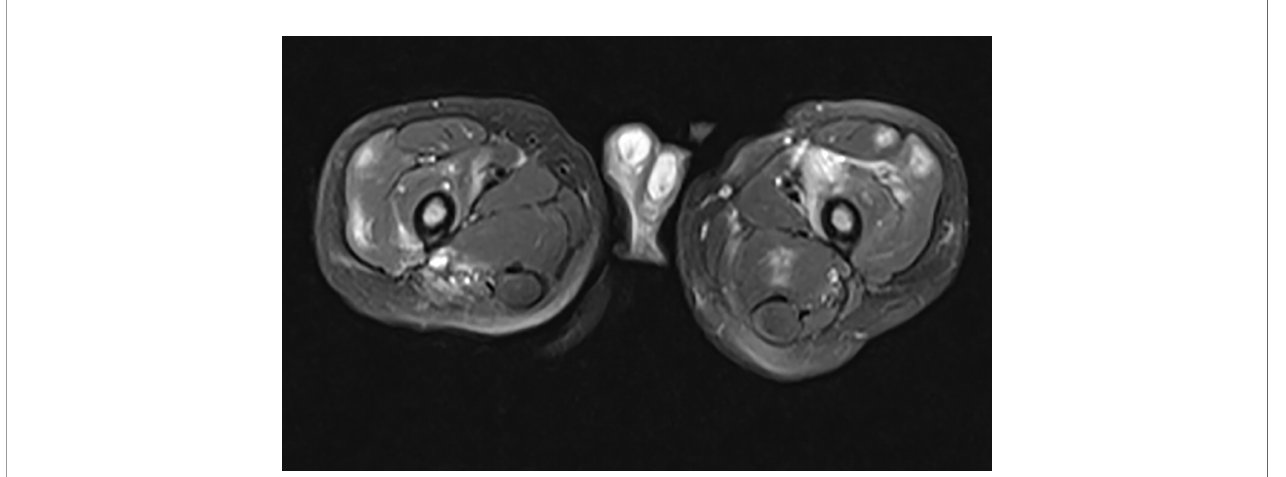
( Figure 9 ). Digital brachial index (DBI) of upper and lower extremities showed abnormal waveform and decreased pressure in several upper and lower digits.